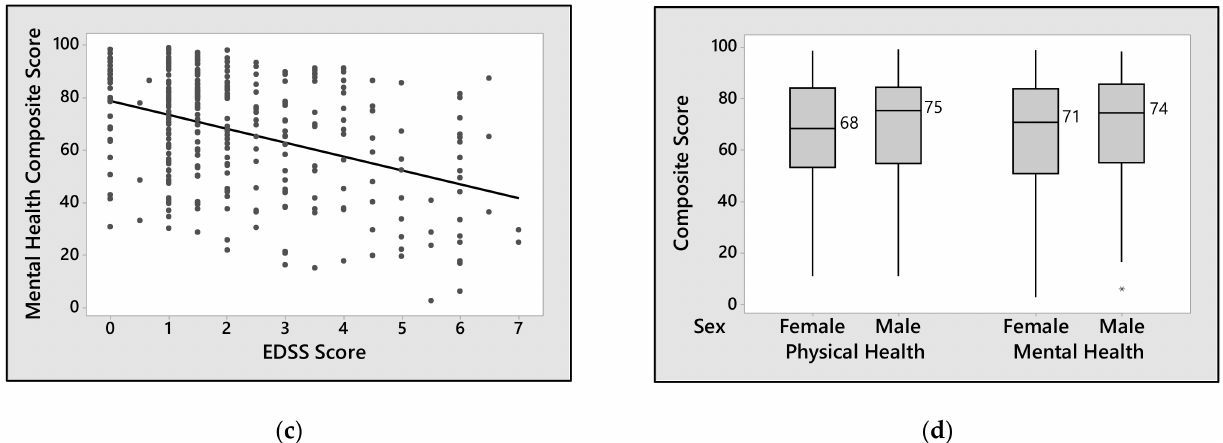
Figure 2. Correlation between MSQoL-54 Composite Scores and clinical characteristics of patients: ( a ) shows the correlation between Physical and Mental Health Composite Scores. ( b , c ) represent the correlation between EDSS Score and Physical or Mental Health Composite Scores, respectively. ( d ) shows the distribution of Physical or Mental Health Composite Scores among female and male participants. Data falling outside the 1st and 3rd quartiles’ range are plotted as outliers of the data (*).